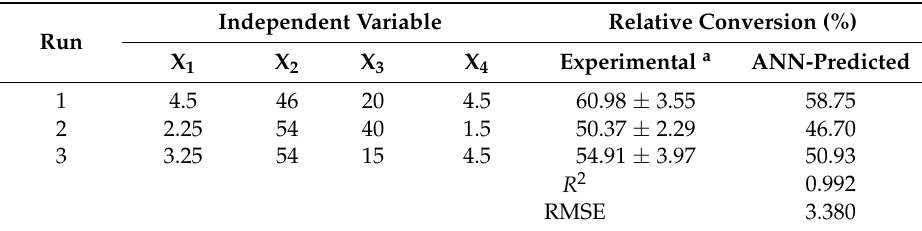
Table 2. Validation of ANN-modeling retinyl laurate synthesis.